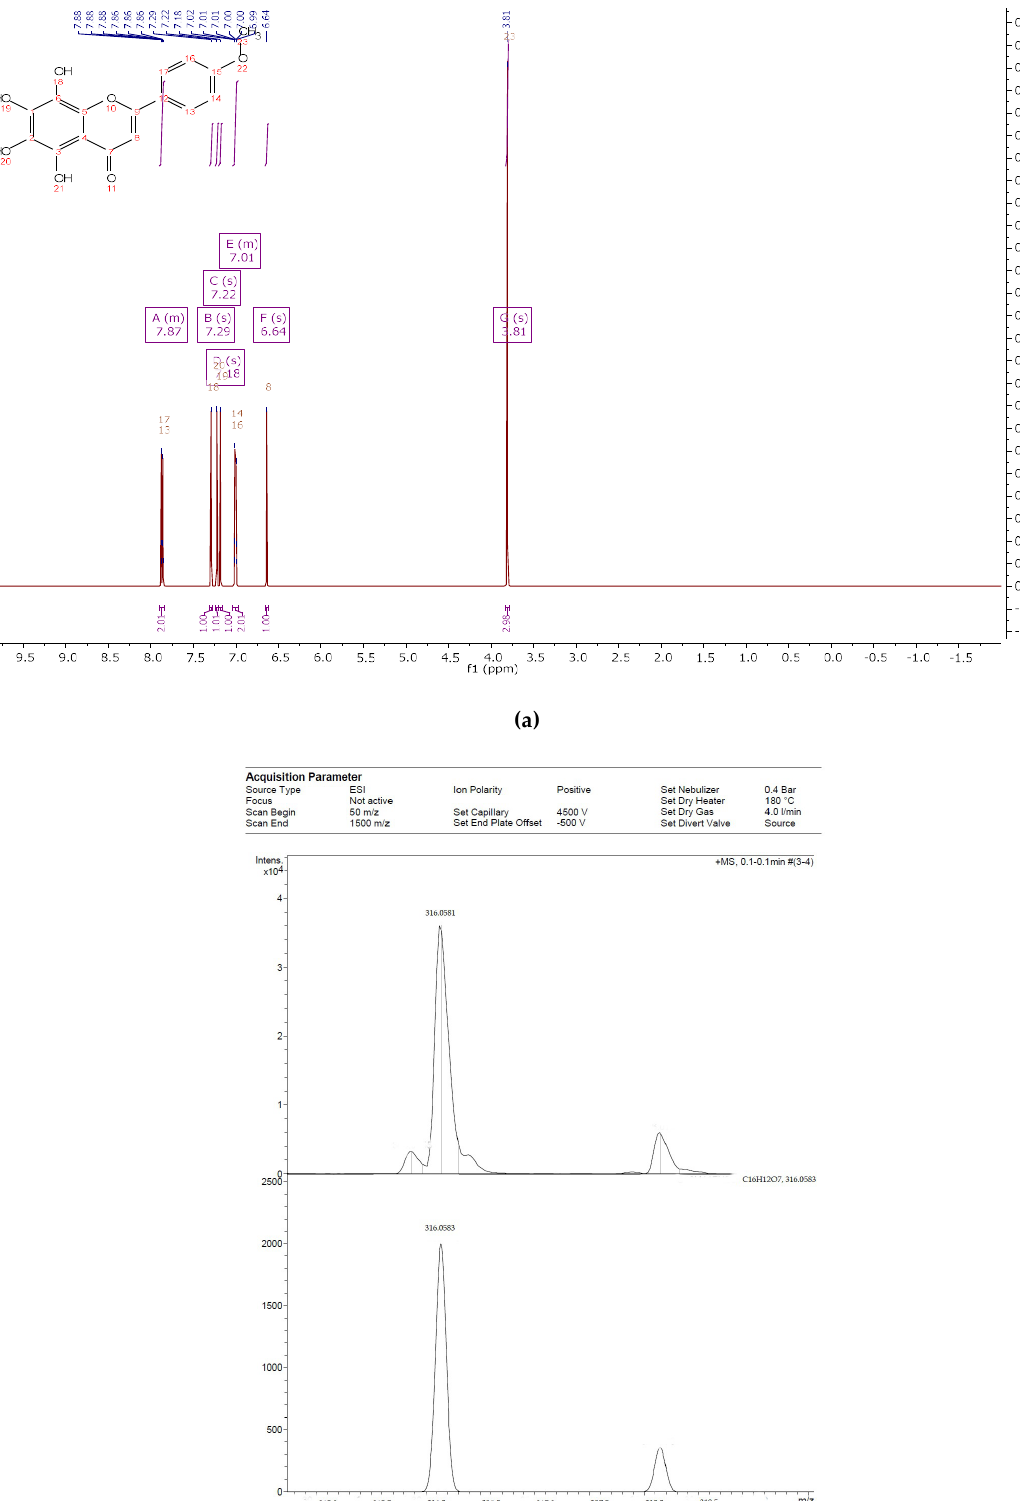
Figure 5. 1 H NMR (a) and HRMS ( b ) spectrum of 5,7-dihydroxy-2-(4-hydroxy-3-(2-(4-hydroxy- phenyl)-4-oxo-4H-chromen-6-yl)phenyl)-4H-chromen-4-one from extracts of callus, cell suspen- sion, and root cultures of Rhodiola rosea .